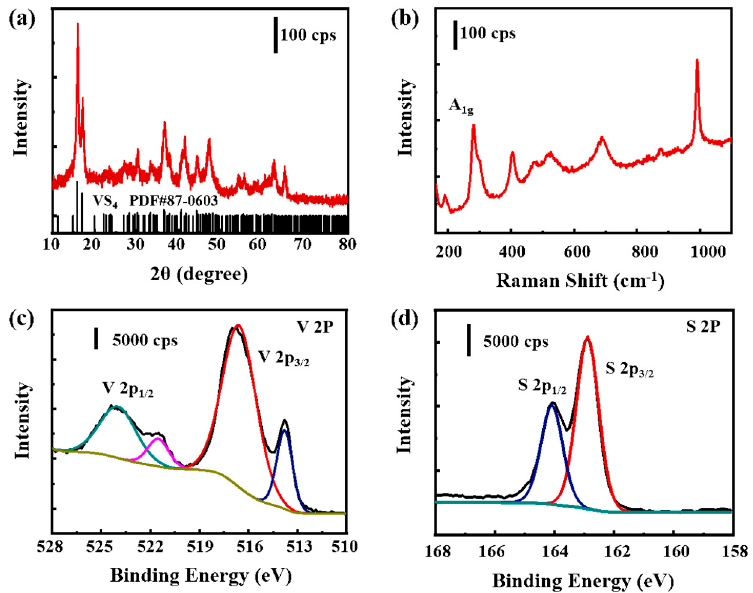
Figure 1. ( a ) XRD pattern, ( b ) Raman spectrum and ( c ), ( d ) XPS spectra of VS 4 nanorods.